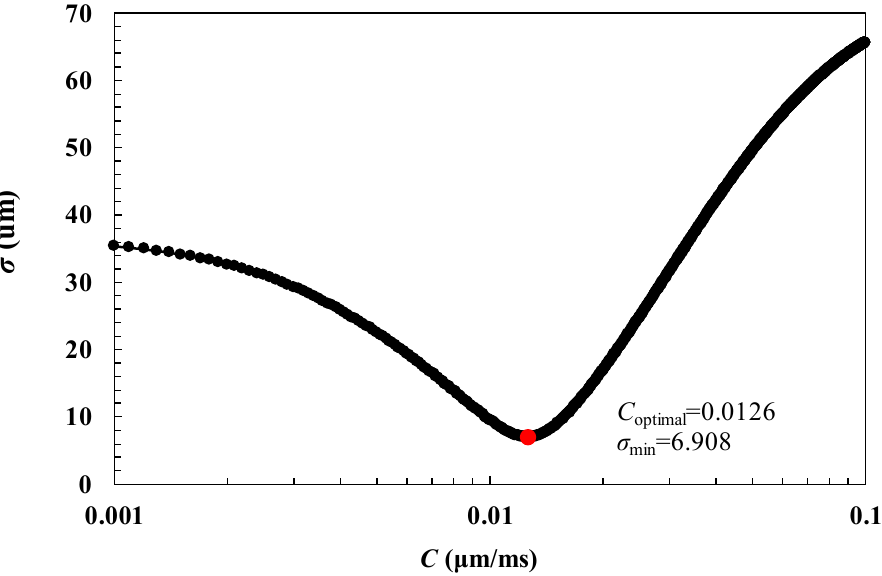
Figure 7. Total errors of linear conversion using different linear conversion coefficients for Z39. 201